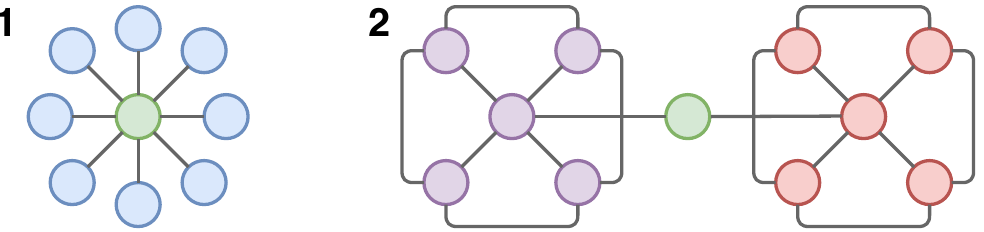
Figure 2. A depiction of node influence in multi-class graphs. The colours denote membership of a node class. ( 1 ) The green node will have a high closeness centrality among the group of nodes. In this case, we assume they all belong to the same class. ( 2 ) The green node will possess a high betweenness centrality between the two class clusters. Here, the green node could belong to either node clusters. Algorithm 1: Sample Nodes using